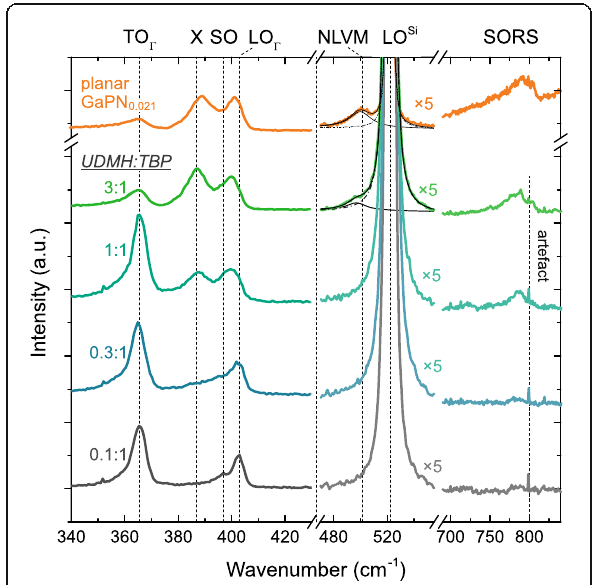
Fig. 3 μ -Raman spectra of GaP(N) NWs grown with UDMH:TBP ratios ranging from 0.1 to 3. A lattice-matched GaPN layer on Si acts as reference (orange). For the deconvolution of the NLVM component Pseudo Voigt functions (of same shape) were used. The sharp line at 800 cm − 1 is a measurement artefact